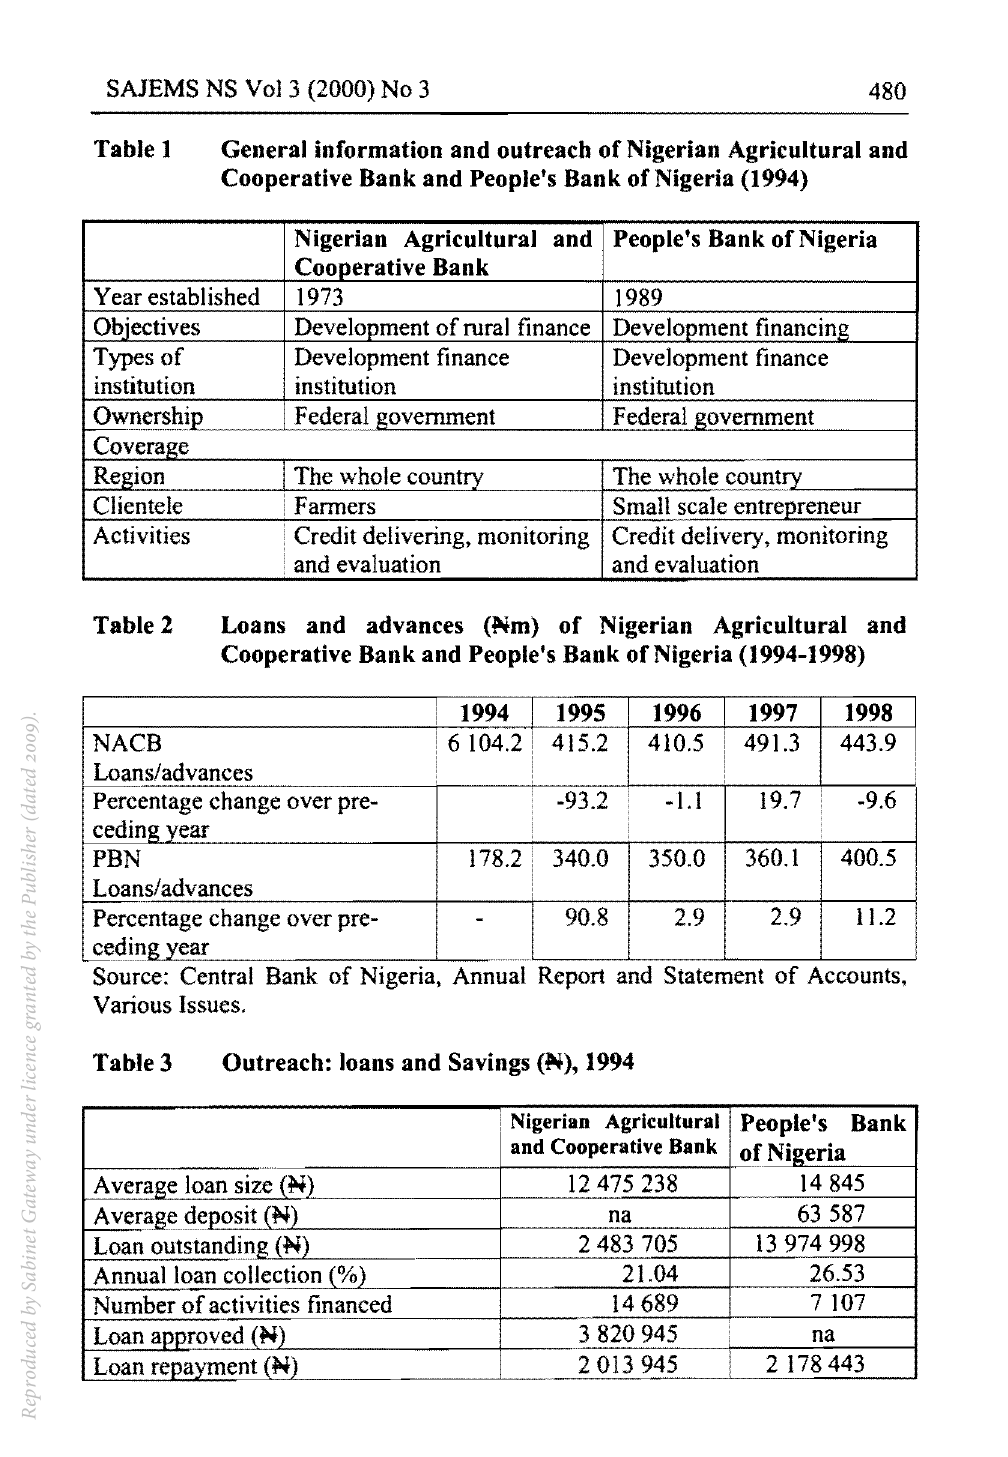
Outreach: loans and Savings (No),